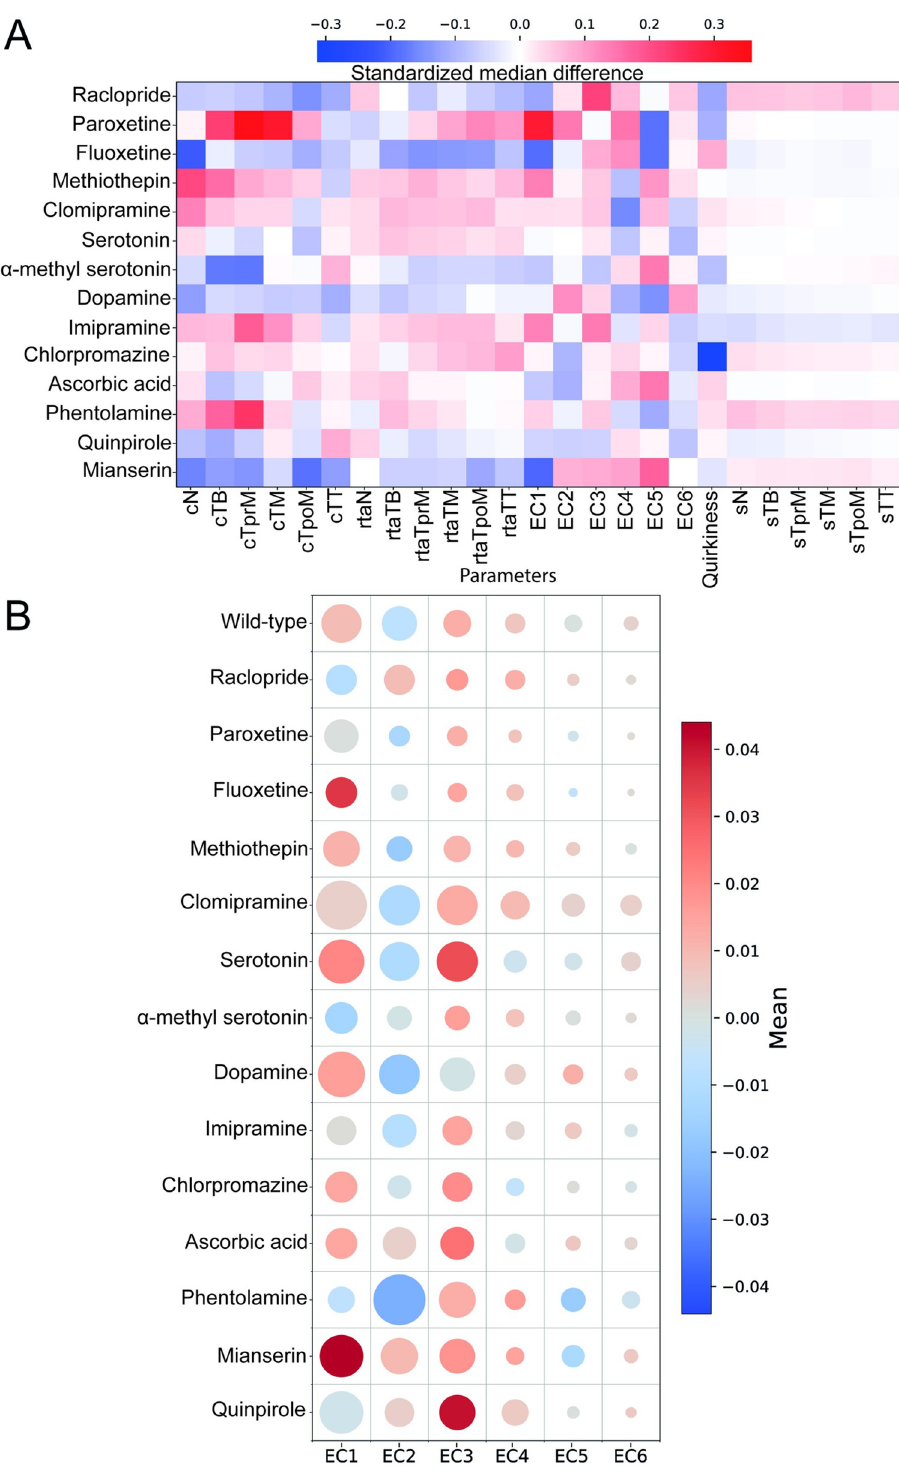
Fig 2. Behavioral AU : AbbreviationlistshavebeencompiledforthoseusedinFigs 2 ; 4 ; and 6 : Pleaseverifythatallentriesarecorrect : barcoding reveals the diverse effects of bioamines in locomotion features. (A) Heatmap showing SMD of 25 features, calculated for drug-treated larvae relative to wild-type larvae. Working concentrations for all drugs are shown in Table 1. Note that SMD values for dopamine are calculated relative to an ascorbic acid solution that was used as a solvent for dopamine (SMD values shown in S7 Table). (B) Bubble grid chart showing effects of drug treatments in the use of eigencionas by swimming larvae, as quantified by the eigencoefficients. Color of circles